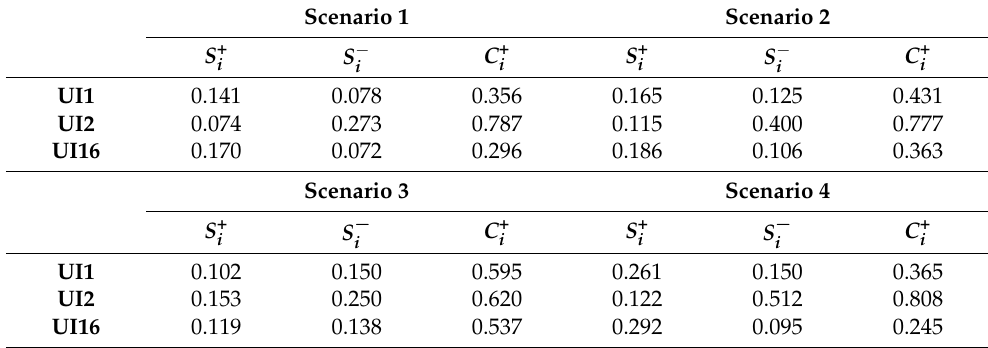
, S − , and C + values under the different i i i